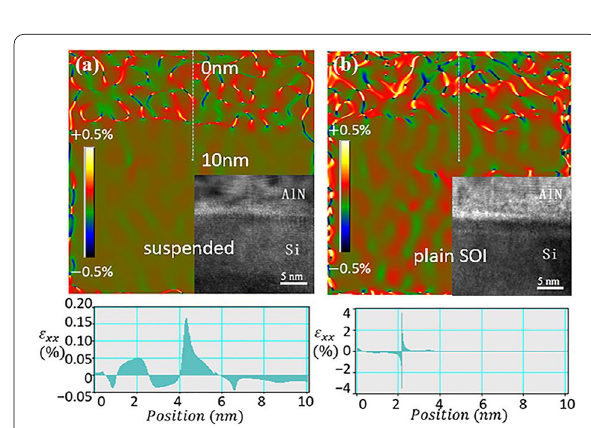
Table 1 Lattice parameter of Si layer near the AlN/Si interface Material Unstrained Si Suspended Si Lattice constant